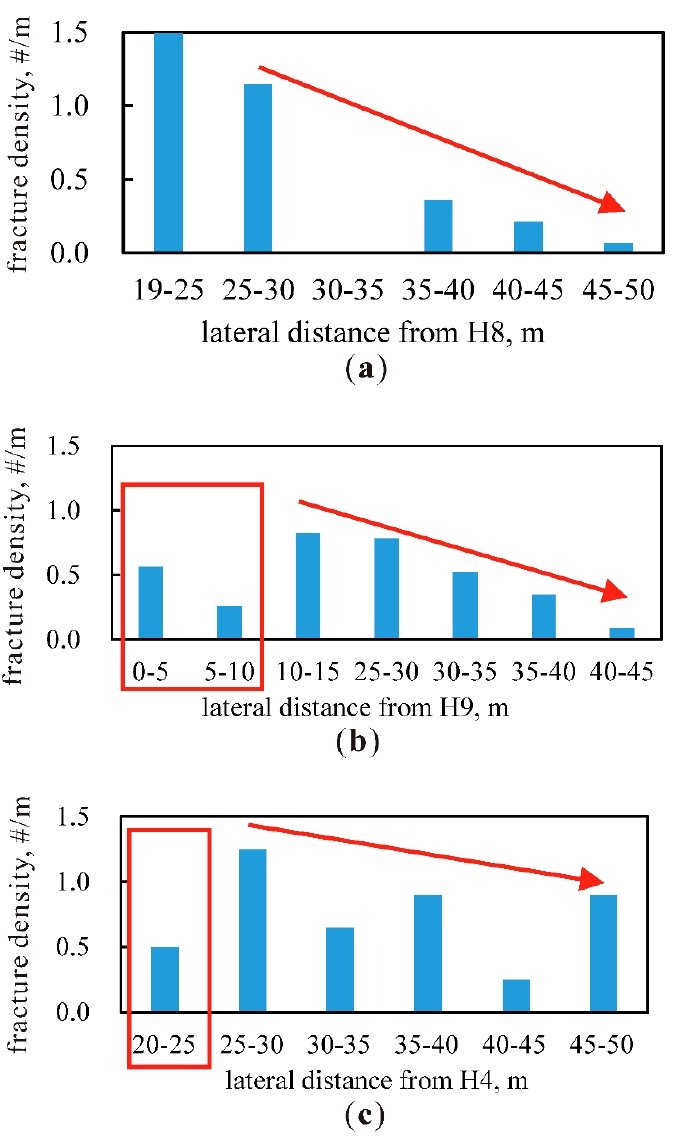
Figure 17. The relationship between the hydraulic fracture density in cores and lateral distance from the horizontal well. ( a ) H8; ( b ) H9; ( c ) H4.